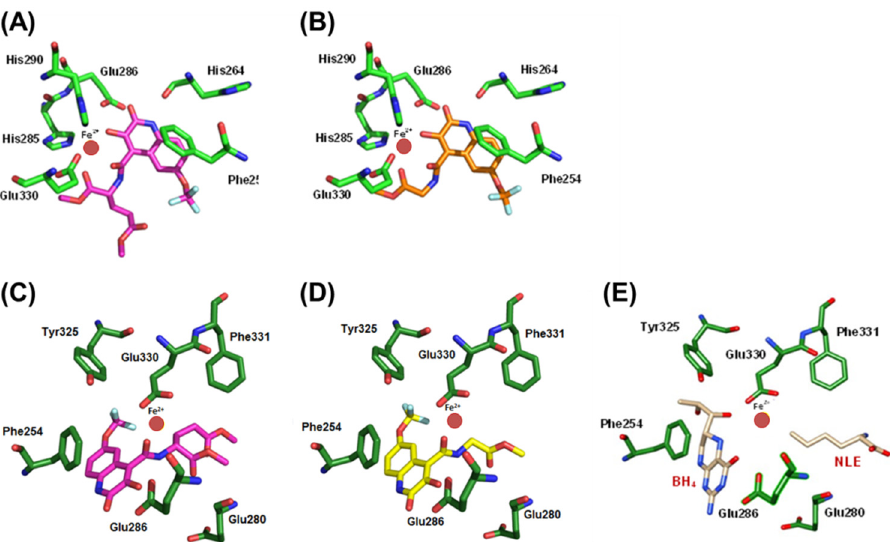
Figure 7. Best docking poses of selected 3HQs into human phenylalanine hydroxylase active site. ( A , B ) Structures of compounds 9 ( A ) and 11 ( B ) in hPAH catalytic center of PDB ID:3PAH. ( C – E ) Structures of compounds 9 ( C ) 11 ( D ) and BH 4 and the substrate analogue norleucine (NLE) ( E ) in hPAH catalytic center of PDB ID:1MMT. The iron atom is depicted in brown and the most relevant interacting residues responsible for iron coordination (His285, His290 and Glu330) or establishing interactions in the binding site are pictured in the figure. Compounds show average scores of 72.98 ( 9 ) and 69.72 ( 11 ) in 3PAH and 72.87 ( 9 ) and 64.63 ( 11 ) in 1MMT.